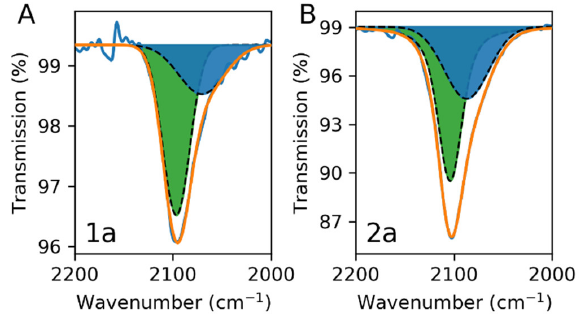
Figure 2. ATR-IR spectra in the 2000–2200 cm −1 window for samples 1a ( A ) and 2a ( B